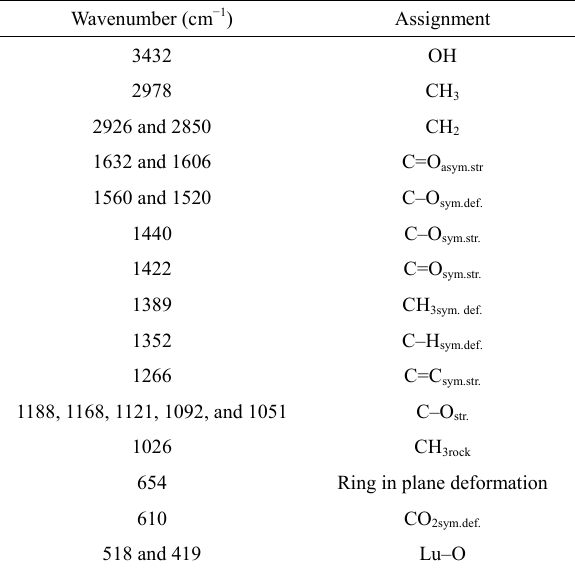
Corresponding group assignments of the FT-IR peaks